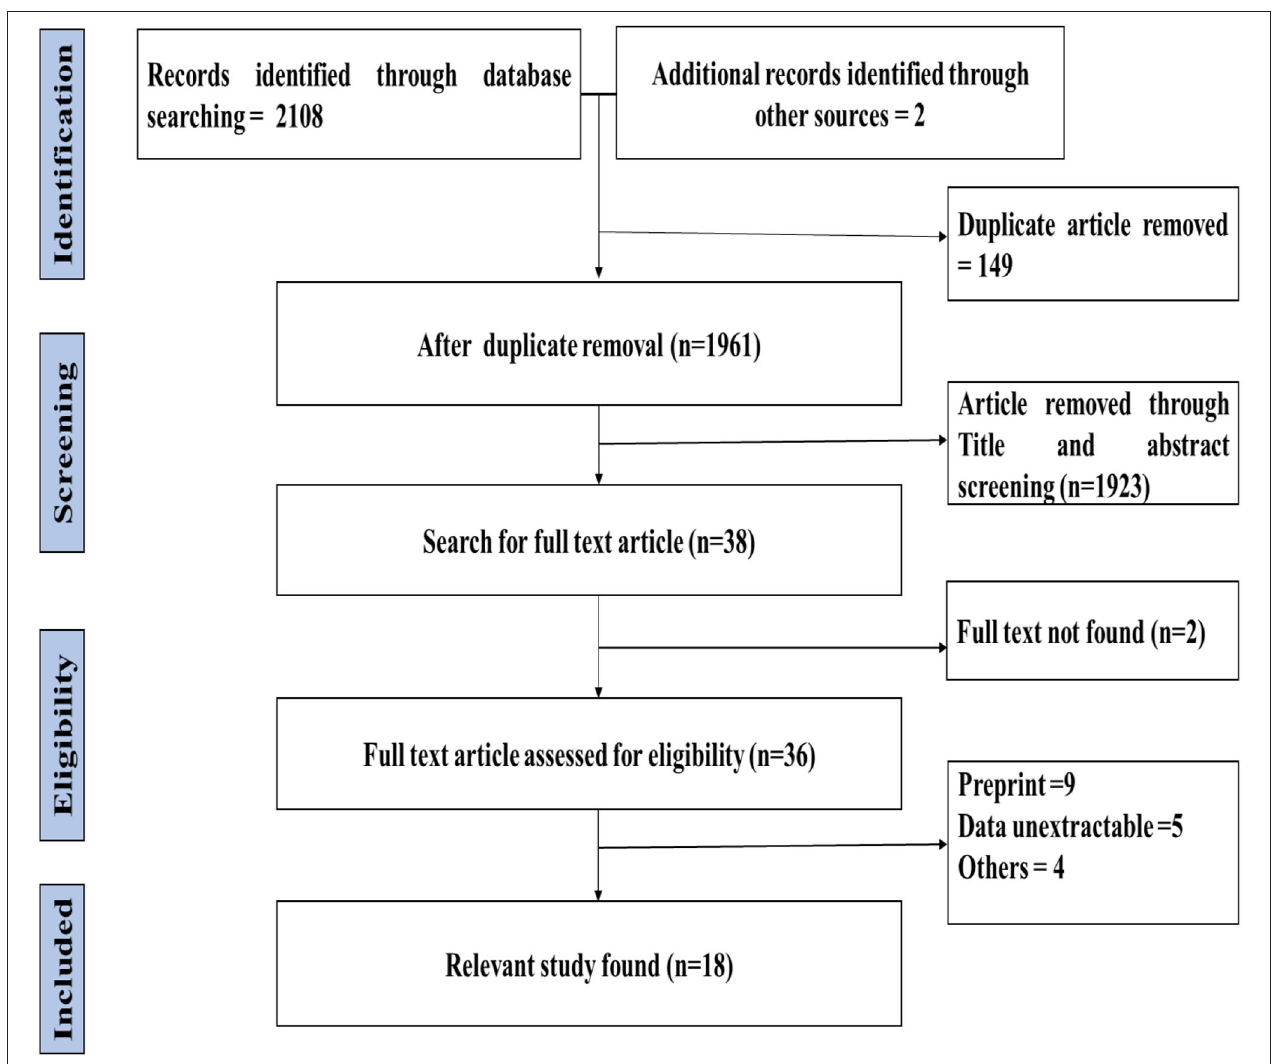
FIGURE 1 | PRISMA flow diagram of literature search and study selection.